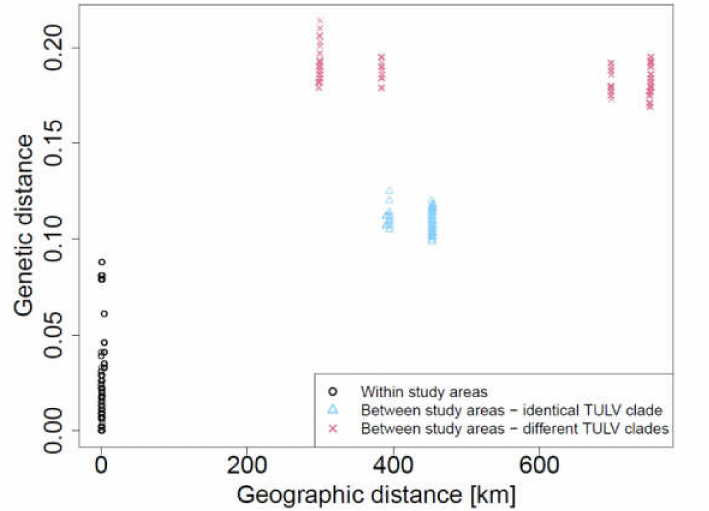
Figure 4. Isolation-by-distance relationship among TULV S segment sequences across the study areas in Germany. Red crosses represent data points for pairwise comparisons among the major phylogeographic clades TULV-CEN.S circulating in the study areas of Weissach and Billerbeck and TULV-CEN.N present in the study areas of Jeeser and